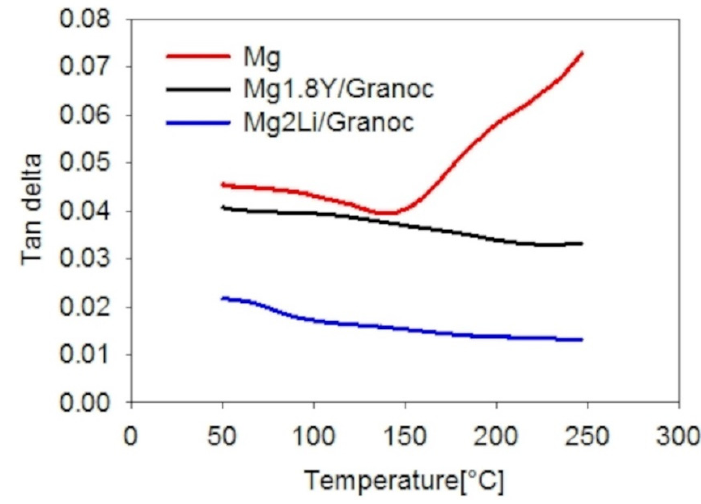
Figure 17. Damping capacity values of the composites with Granoc fibers.